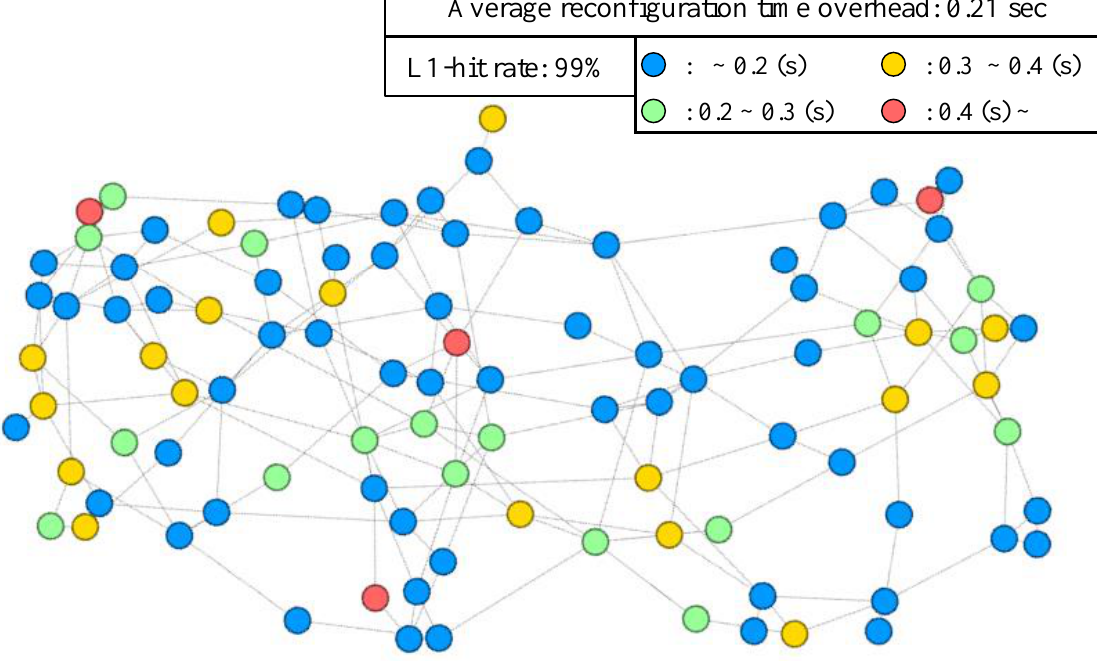
Figure 10. Large-scale simulation results with reconfiguration